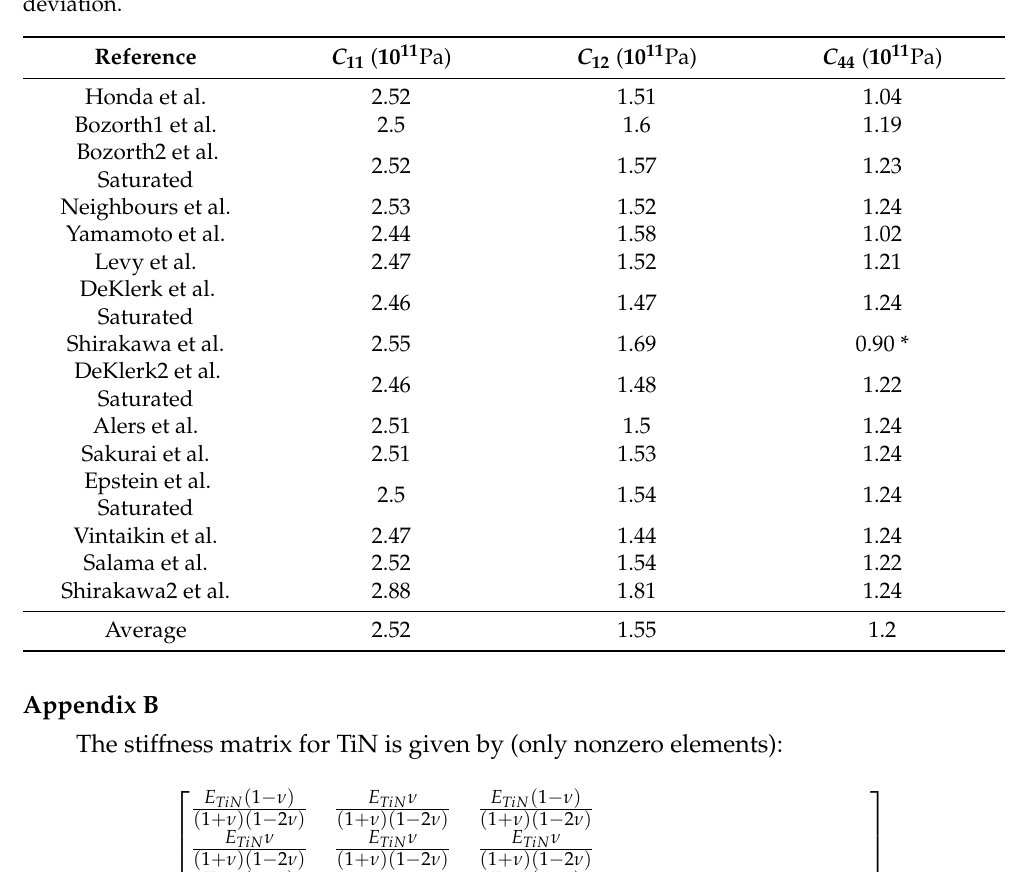
Table A2. Summary of the elastic constants of Ni gathered from [32]. * Omitted values due to high deviation.